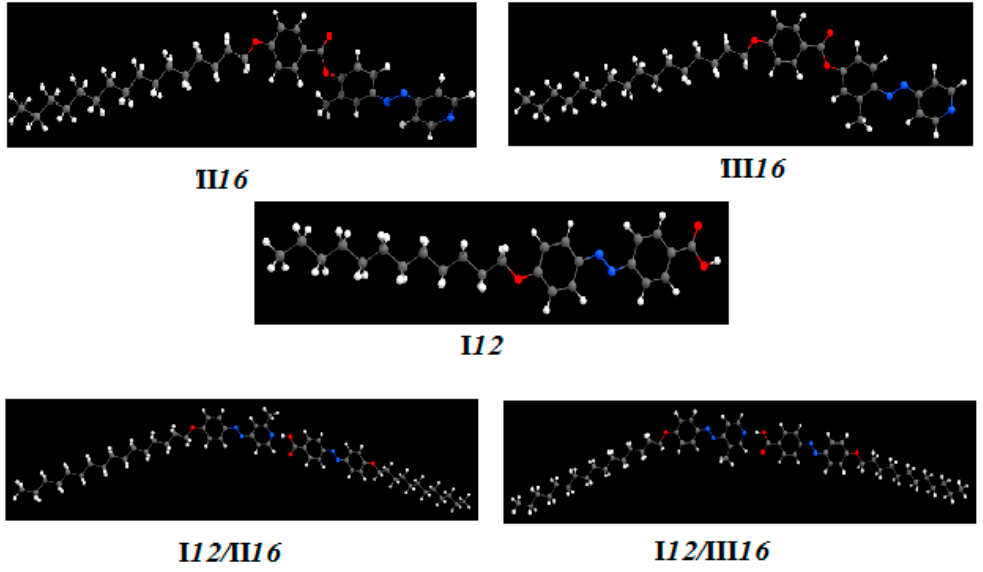
Figure 5. Calculated geometrical structure of I 12 , II 16 , III 16 , I 12 /II 16 and I 12 /III 16 .